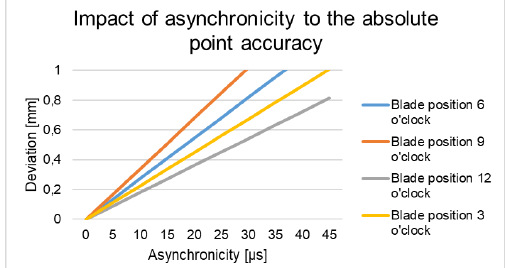
Figure 4. Exemplary representation of the effects of asynchronicity to point accuracy